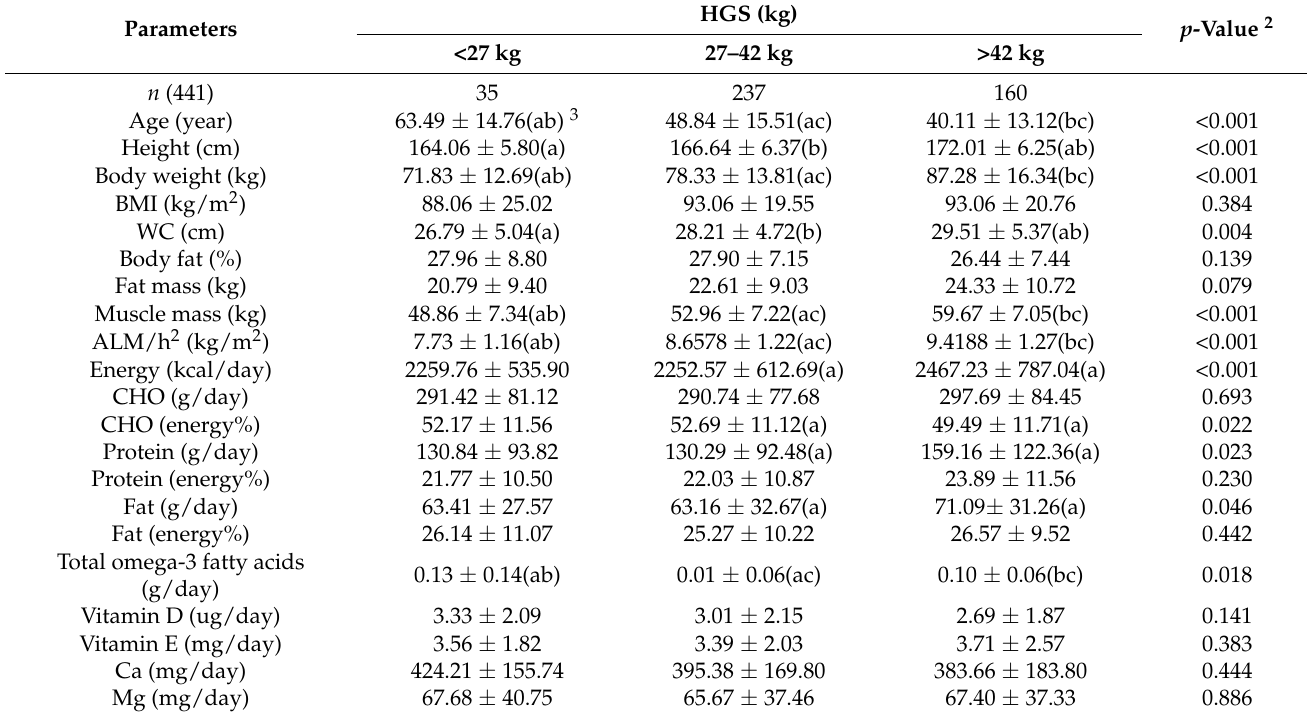
Table 3. General characteristics and nutrient intake of study participants based on different HGS reference values 1